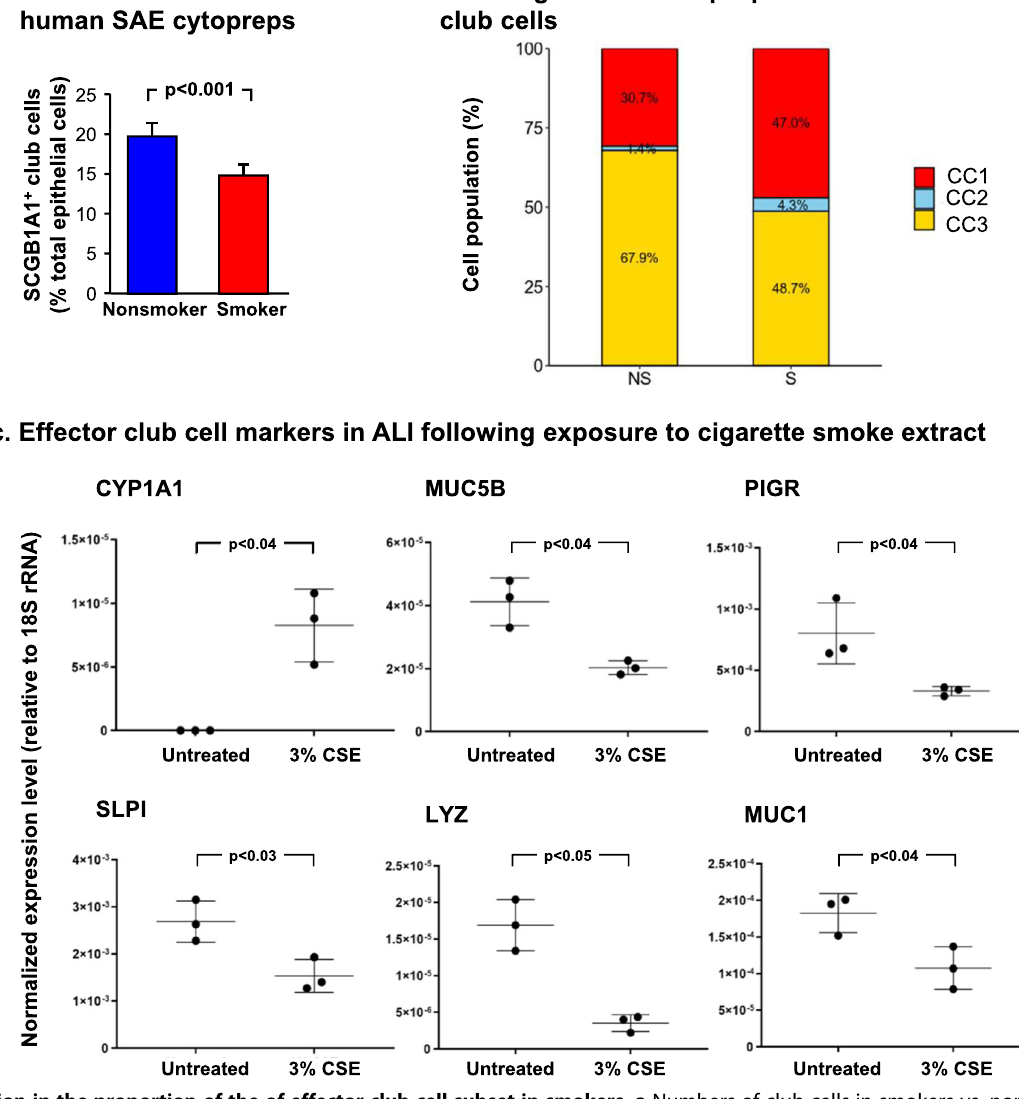
Fig. 6 Reduction in the proportion of the of effector club cell subset in smokers. a Numbers of club cells in smokers vs. nonsmokers. Club cells from nonsmoker and smoker human small airway epithelium (SAE) cytopreps, identi fi ed by SCGB1A1 + immunostaining and absence of KRT5, were quanti fi ed and compared against total cells, quanti fi ed by DAPI staining, per cytoprep. Three samples of each phenotype were evaluated by a blinded observer, with over 500 total cells per sample; plots show mean ± standard error. b Proportion of club cells exhibiting characteristics of subclusters 1 (progenitor), 2 (proliferative), and 3 (effector) in the population of club cells derived from nonsmokers and smokers. c Effect of cigarette smoke extract (CSE) exposure on differentiation of small airway epithelial club cells. Exposure of basal cells differentiated on air liquid interface (ALI) to cigarette smoke extract (3% Marlboro Red) led to a decrease in defense-related transcript in cells: CYP1A1, positive control demonstrating exposure to cigarette smoke extract; MUC5B; PIGR; SLPI; LYZ; and MUC1. Values are expressed as normalized expression relative to 18S rRNA. Each point represents one well of an experiment done in triplicate; plot shows mean ± standard deviation; p values are from a two-sided unequal variance Student ’ s t -test. All data is from ALI day